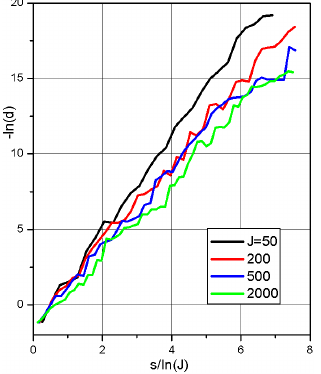
Figure 11. 5-solver, 5-scheme, Neumann, circle,